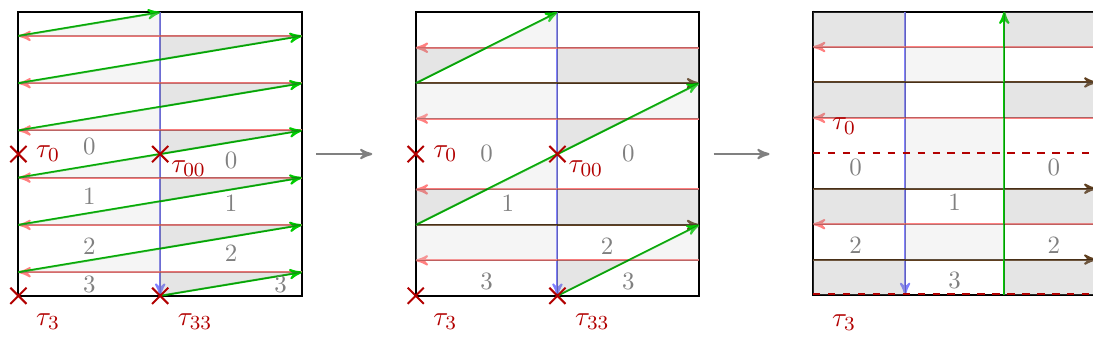
Figure 10. The chain of five-brane diagrams connected by mass deformation for n = 6 : C 2 / Z 6 × C → L 2 , 4 , 2 → L 3 , 3 , 3 , the number of vectors remains n + 2 = 8 all along. It holds also with the orientifold projection, provided a Z 2 symmetry is preserved.